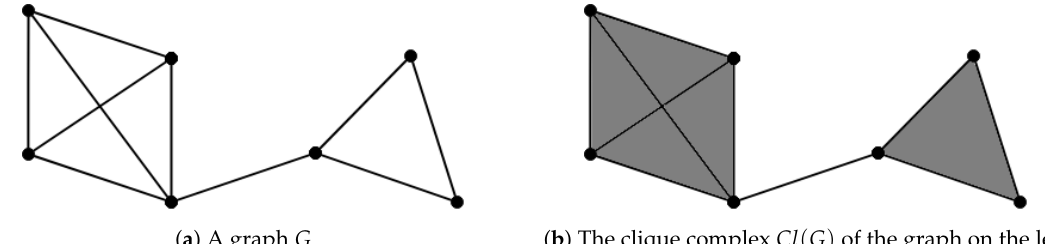
Figure 2. An example for constructing the clique complex of a graph (borrowed from